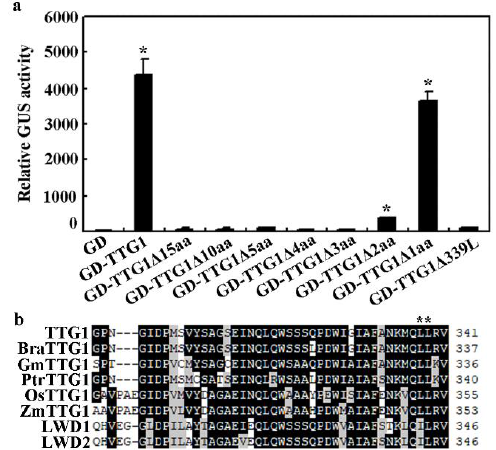
Figure 6. Interaction of full-length and truncated TTG1 with GL3. ( a ) Interaction of TTG1, TTG1Δ15aa, TTG1Δ10aa, TTG1Δ5aa, TTG1Δ4aa, TTG1Δ3aa, TTG1Δ2aa, TTG1Δ1aa, and TTG1Δ339L with GL3 in transfected protoplasts. Protoplasts were isolated from 3 to 4 -week-old Col Arabidopsis rosette leaves. Plasmids of the effector genes GD-TTG1 , GD- TTG1Δ15aa , GD- TTG1Δ10aa , GD- TTG1Δ5aa , GD- TTG1Δ4aa , GD- TTG1Δ3aa , GD- TTG1Δ2aa , GD- TTG1Δ1aa , or GD- TTG1Δ339L were co-transfected with the reporter gene Gal4:GUS and the effector gene HA-GL3 into protoplasts. The protoplasts were incubated in darkness for 20 – 22 h, and then GUS activity was assayed. Co-transfection of GD with Gal4:GUS and HA-GL3 was used as a control. Data represents the mean ± SD of three repeats. *, Significantly different from that in the GD control (Student’s t test, p < 0.0001). ( b ) Alignment of the C-terminal amino acids of TTG1, BraTTG1, GmTTG1, PtrTTG1, OsTTG1, ZmTTG1, AtLWD1, and AtLWD2 proteins. Identical amino acids are shaded in black, and similar in grey.